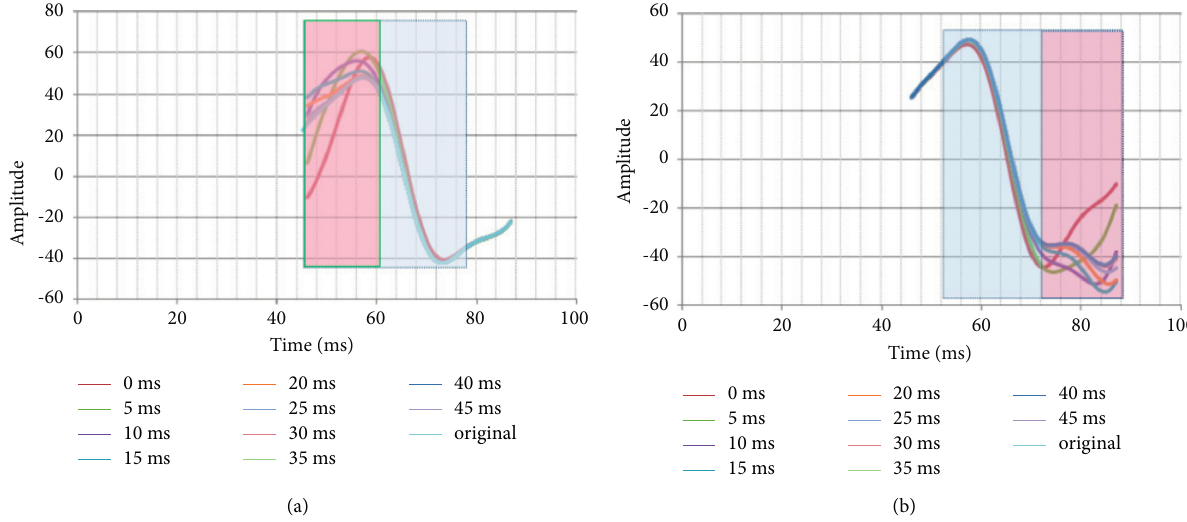
Figure 21: Comparison between waveforms of the target layers at different offset time. (a) Upward movement of the interference layer. (b) Downward movement of the interference